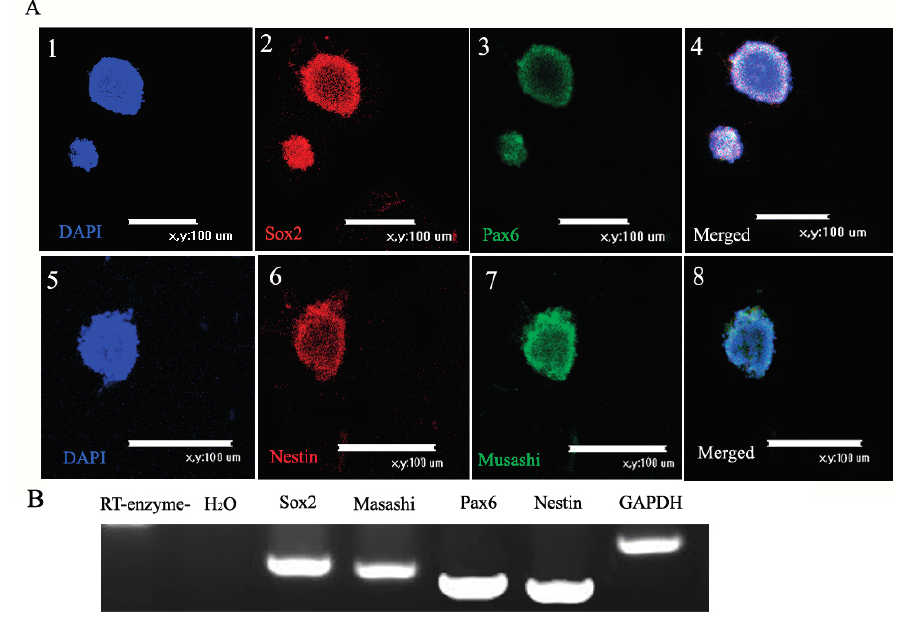
Figure 2. Markers of neural stem cells (NSCs). ( A ) Immunofluorescence of NSCs: ( 1 ) Nuclear counterstaining (blue) with DAPI; ( 2 ) immunofluorescence staining of the marker Sox2 (red) and ( 3 ) Pax6 (green); ( 4 ) Merged picture to show Sox2 and Pax6 co-expressed in NSCs. Scale bar = 100 μ m ( 1 – 4 ); ( 5 ) Nuclear counterstaining (blue) with DAPI, ( 6 ) immunofluorescence staining of the marker Nestin (red) and ( 7 ) Musashi (green); ( 8 ) Merged picture to show Nestin and Musashi co-expressed in NSCs. Scale bar = 100 μ m ( 5 – 8 ); and ( B ) DNA electrophoretic analysis of cell marker. RT-PCR analysis of NSCs indicated expression of Sox2, Musashi, Pax6 and Nestin. GAPDH served as the internal